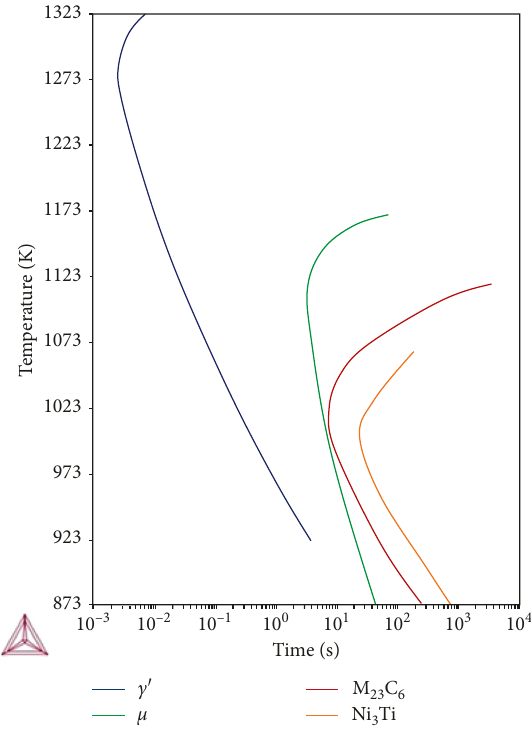
Figure 6: Time-temperature-precipitation diagram for IN-792